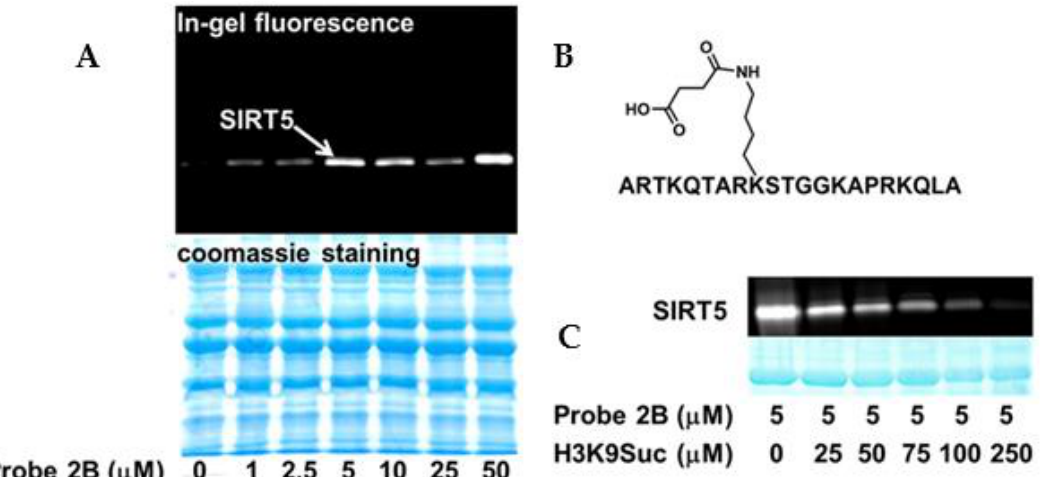
Figure 4. Labeling of SIRT5 by probe 2B. ( A ) Dose-dependent labeling of SIRT5 by probe 2B in recombinantly expressed, partially purified sirtuin mixture. SIRT1, SIRT2, SIRT3, SIRT5, and SIRT6 were mixed and incubated with 500 µ M NAD + and increasing concentrations of 2B. The samples were incubated at 37 ◦ C for 10 min and subjected to UV irradiation for 20 min, and then “click” conjugated to TAMRA-azide; ( B ) Chemical structure of H3K9Suc; ( C ) Peptide competition. The labeling of SIRT5 by probe 2B decreased with increasing concentrations of the competitor peptide, H3K9Suc.